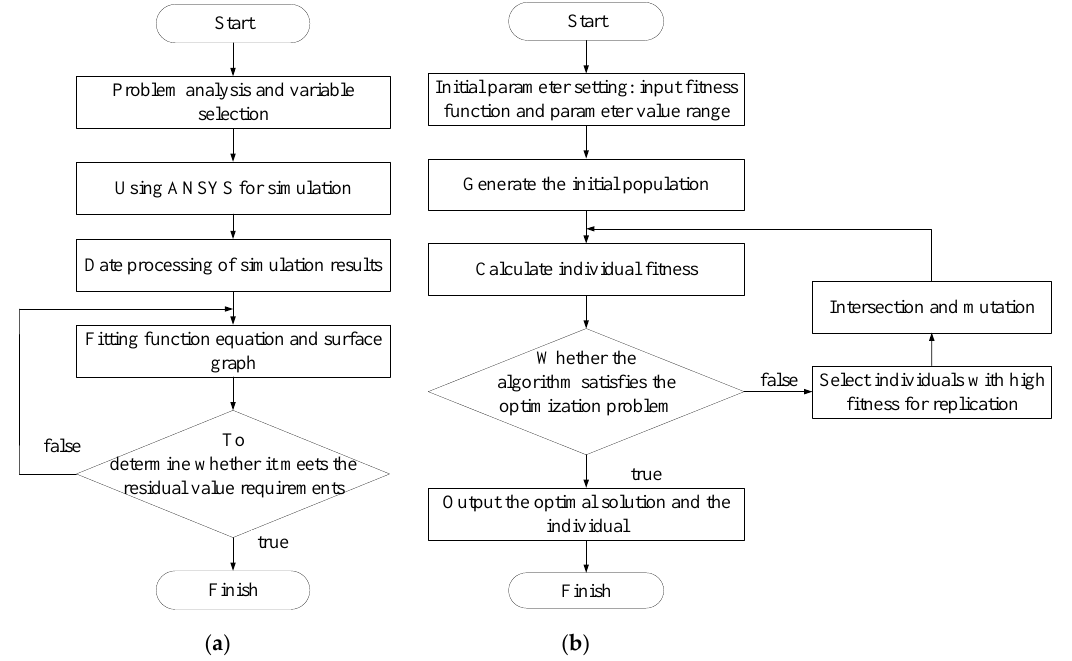
Figure 7. Optimization process of genetic algorithm: ( a ) flow chart of fitting function; ( b ) flow chart of genetic algorithm.